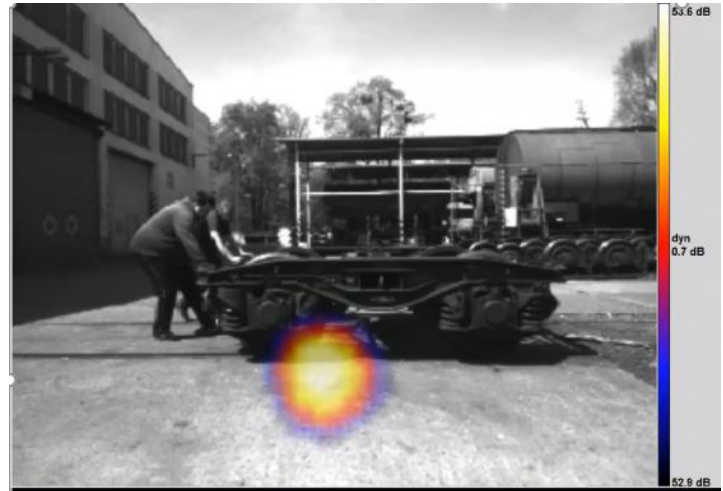
Figure 8. A picture from the acoustic camera during bogie motion (uninsulated part of the bogie on the left, insulation applied on the right).